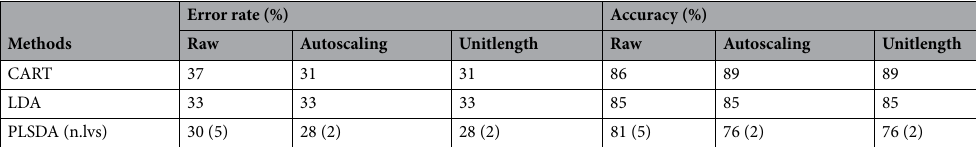
Table 3. The cross validation results of botanical origin identification based on electronic nose. n.lvs in the parenthesis denotes the number of latent variables optimized by eight-fold cross-validation.